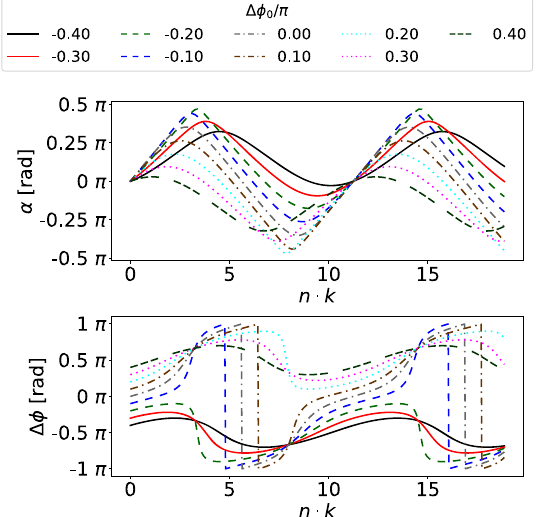
FIG. 6. Observation of unbound oscillation of Δ ϕ . The fit results correspond to k ¼ ð 8 . 51 (cid:2) 0 . 58 Þ × 10 − 7 , q ¼ 0 . 52 (cid:2) 0 . 16 and C ¼ 0 . 205 (cid:2) 0 . 087 at a χ 2 = NDF of 82 . 8 = 74